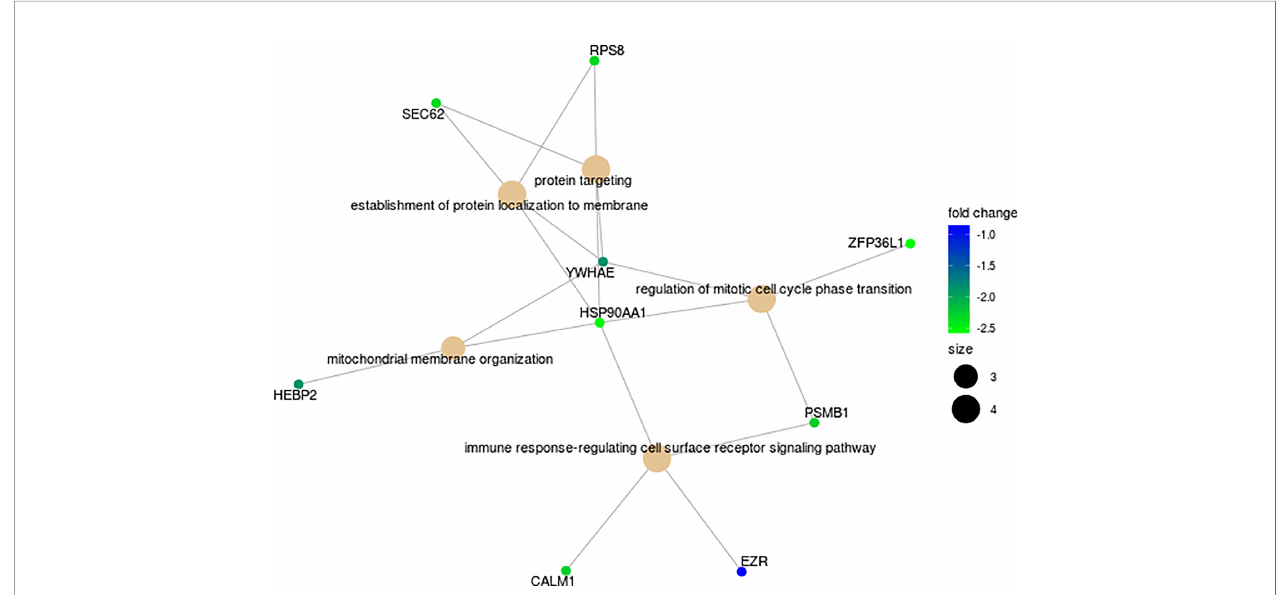
FIGURE 5 | Functional enrichment map of 16 putative target DEGs for the miRNAs (MIR4278, MIR4422 and MIR4779) in cervical cancer stem-like cells from Non- Responders (n=10) patients compared to Responders (n=21). Associations among GO Biological processes are represented by their shared genes. Node size indicates the number of genes contained in the pathway, and color gradient shows the corresponding log2 fold